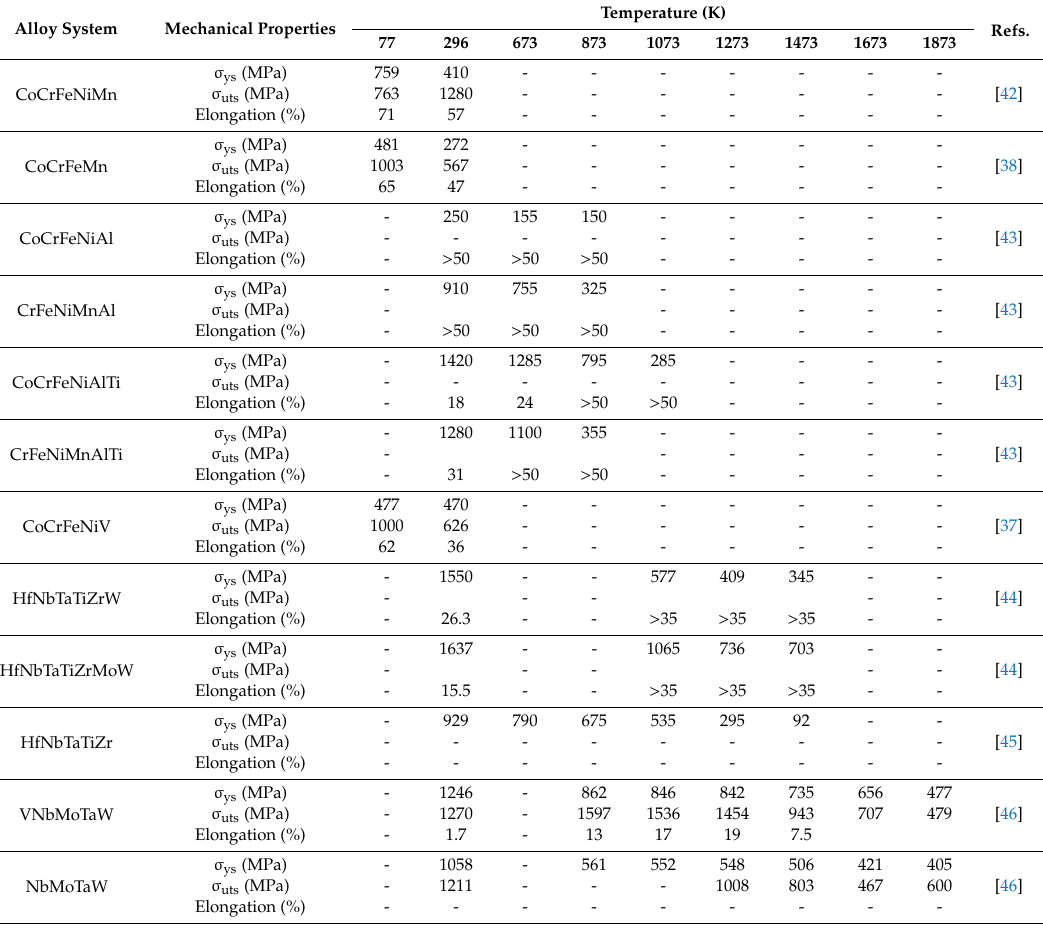
Table 1. Mechanical properties of various high entropy alloys (HEAs) under di ff erent temperatures. Alloy